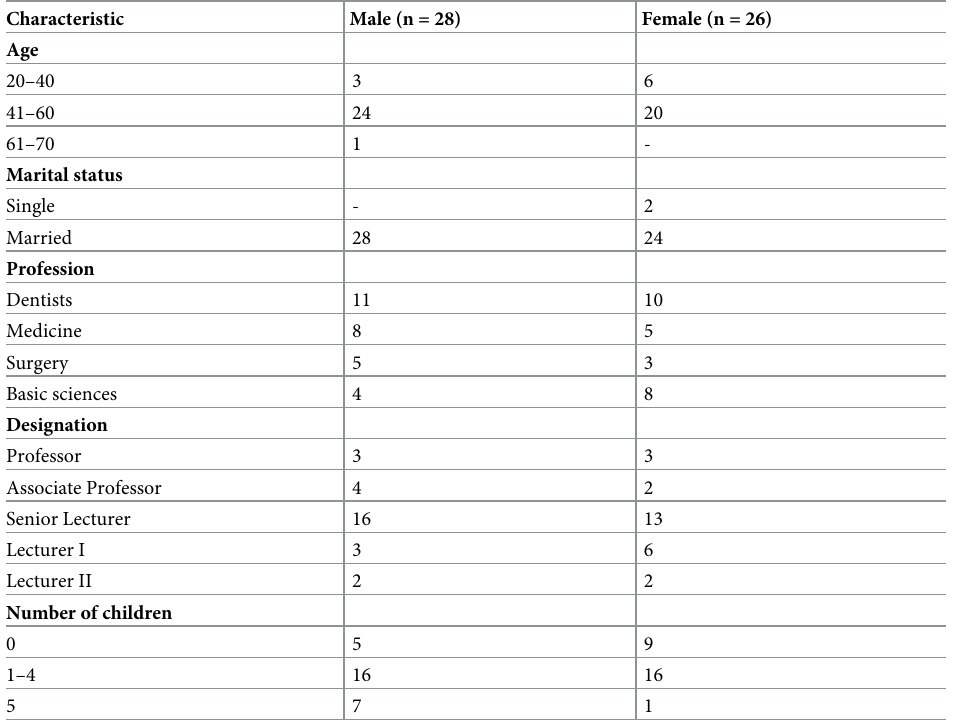
Table 2. Sociodemographic profile of participants (N =